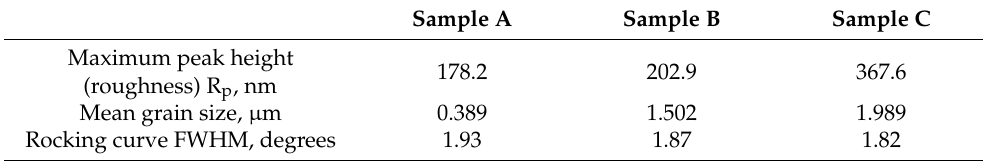
Table 1. Characteristic parameters for the as-grown β -Ga 2 O 3 film structure and morphology. Figure 3. ( a ) A typical X-ray diffraction pattern of a Ga 2 O 3 film on c-plane sapphire, all samples gave qualitatively similar patterns. The inset shows rocking curves ( ω -scans) of the ( − 201) peak of the studied samples. ( b ) A transmission electron microscope image of the Ga 2 O 3 /sapphire interface in Sample C, showing the Ga 2 O 3 growth direction and interplanar spacing, with ( c ) selected area elec- tron diffraction pattern of the Ga 2 O 3 film. ( d ) Scanning electron image of the cross-section cut of Sample C. ( e ) An example of a low-angle grain boundary typically observed in Sample C.